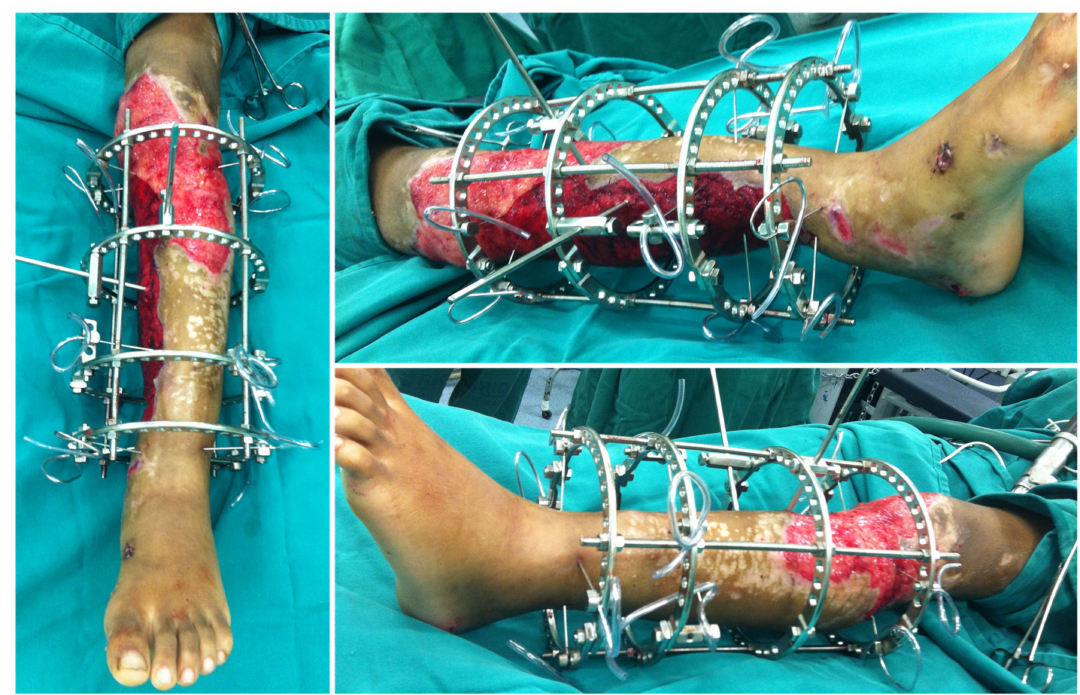
Figure 5. Aspect of the leg one week after the Ilizarov circular frame was applied. No wound closure either using NPWT, flaps, or skin graft was done. There were no signs of ischemia or vascular insufficiency.